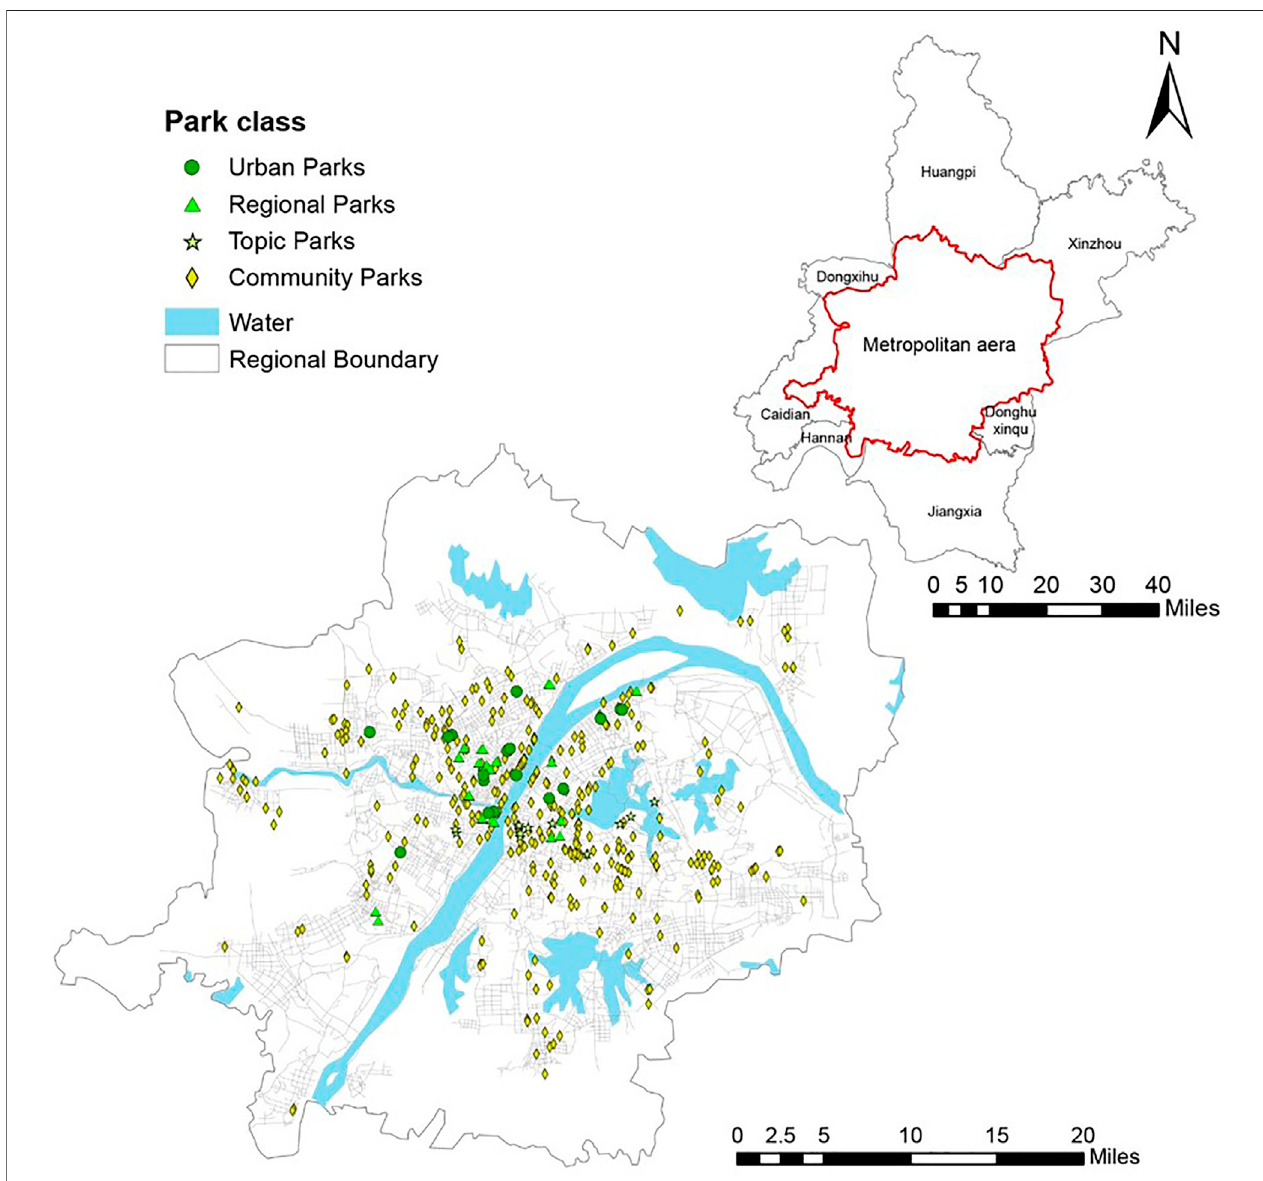
FIGURE 1 | Location of the study area and spatial distribution of